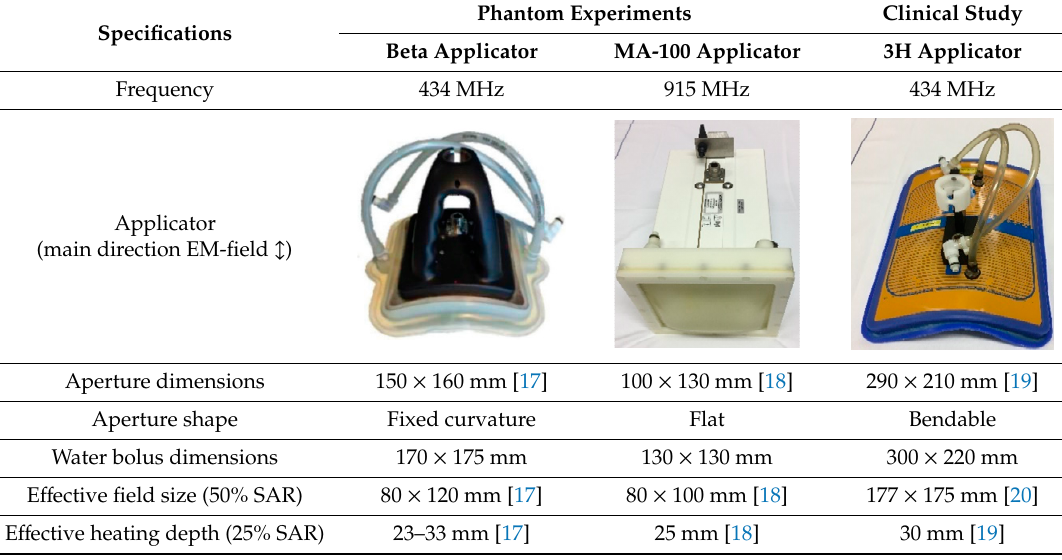
Table 1. Specifications of the applicators used in the phantom experiments and the clinical study; the Beta applicator (Medlogix, Rome, Italy), MA-100 applicator (Pyrexar, Salt Lake City, USA), and 3H applicator (Istok, Fryazino, Russia). SAR: specific absorbed rate.